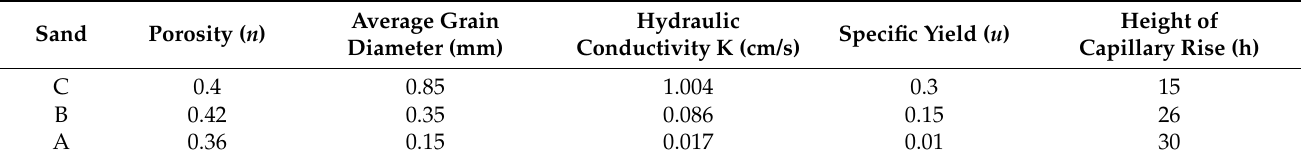
Figure 2. Particle size analysis curve of ( a ) sand A, ( b ) sand B, and ( c ) sand C. Table 1. Physical parameters of sand used in the experiment.